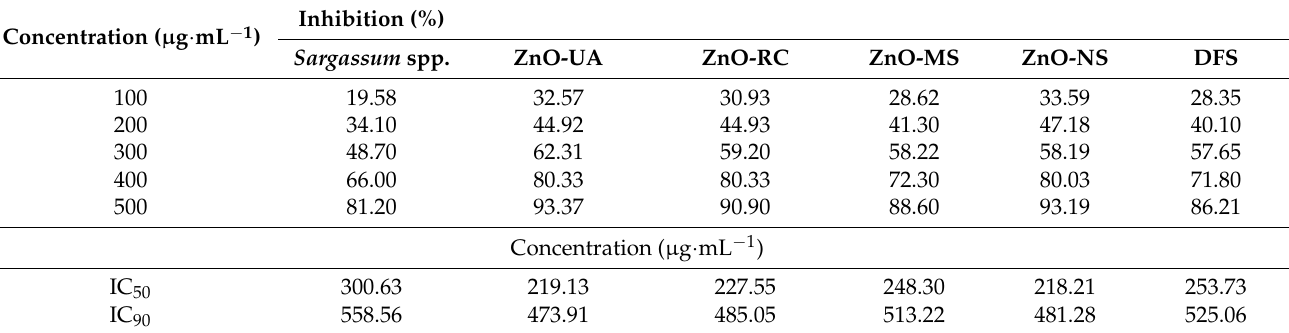
Figure 9. Anti-inflammatory activity of sargassum extract, green synthesized ZnO-UA, ZnO-RC, ZnO-MS nanoparticles, and DFS. Table 1. Percentage of protein denaturation inhibition from extract, all synthesized ZnO nanoparticles, and DFS as a positive